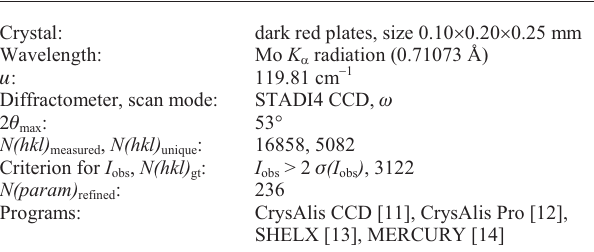
Table 1. Data collection and